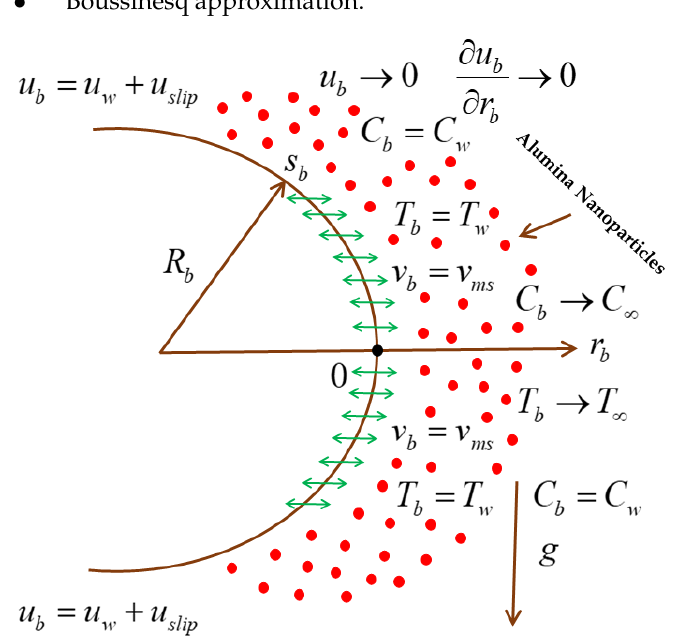
Figure 1. Physical model of the stretching curved surface embedded nanofluid.